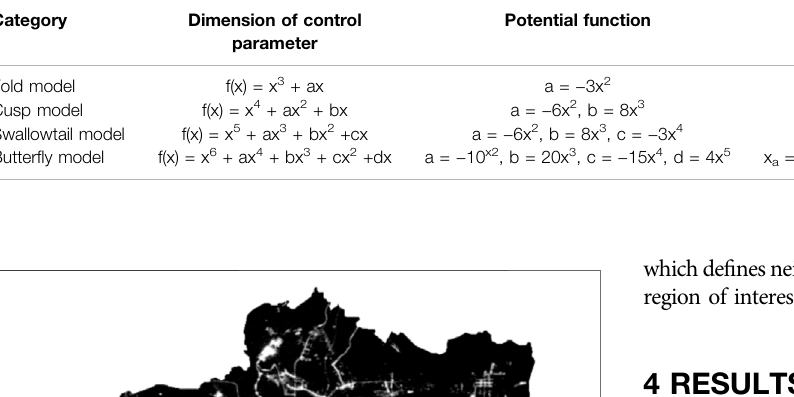
TABLE 3 | Summary of possible catastrophe